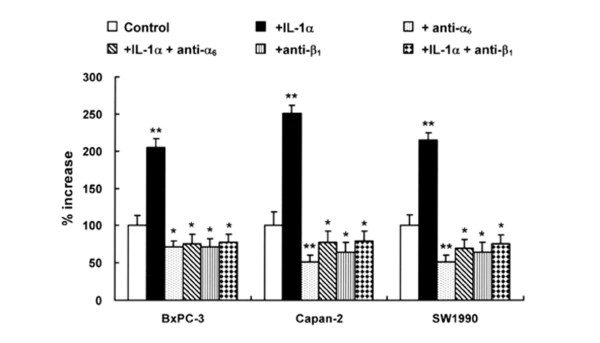
Effect of IL-1α on pancreatic cancer cell adhesion. Pancreatic cancer cells were cultured with 10 ng/ml IL-1α, with 10 ng/ml IL-1α and 0.5 μg/ml anti-α6 integrin antibody, or with 0.5 μg/ml anti-β1 integrin antibody for 24 h, after which the cell adhesion assay was performed at 37°C for 30 min. Bars indicate the s.d. **: p < 0.01, *: p < 0.05.